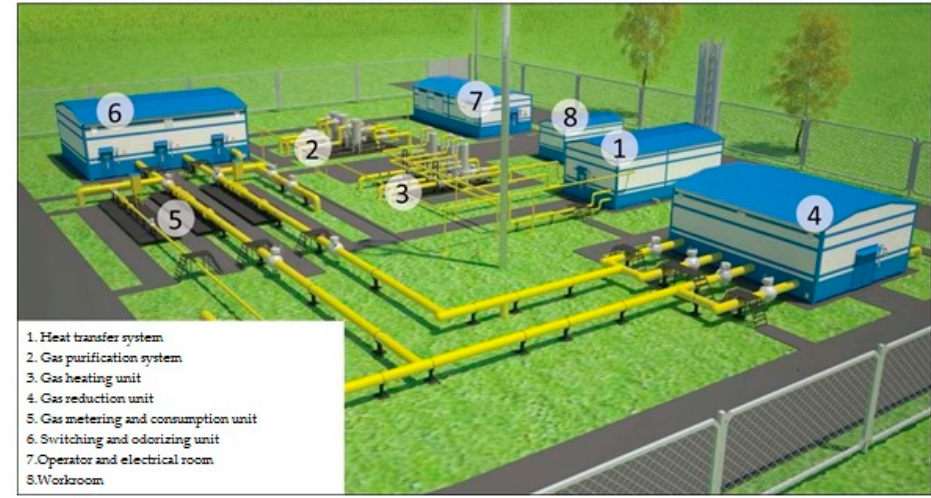
Figure 3. The diagram of a gas distribution station.